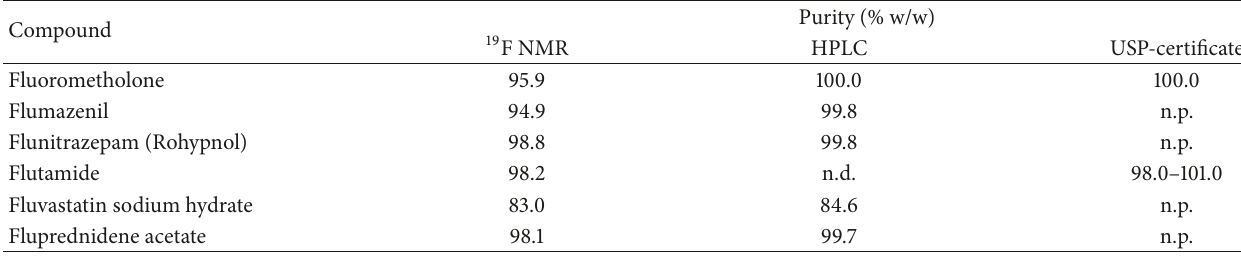
soluble fluorinated pharmaceuticals. 6